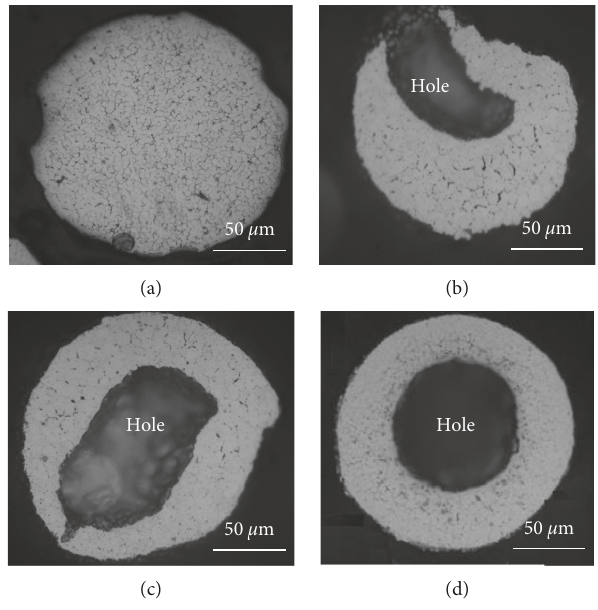
Figure 6: Several different morphologies of Ni-Pb alloy hollow particles at